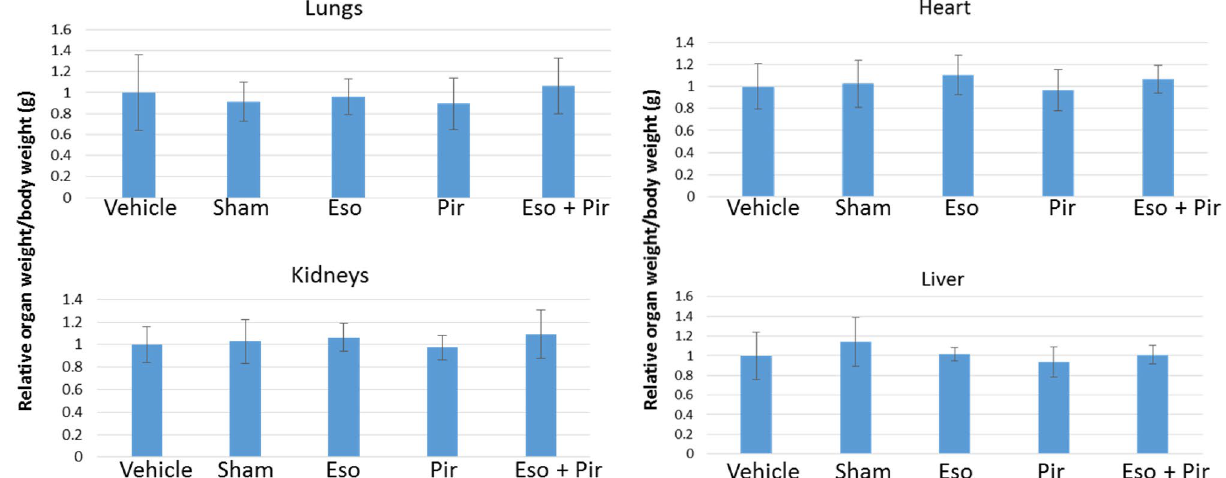
Figure 6. Measurement of organ weight in a TGFβ-induced lung fibrosis mouse model. The weight of the lungs, heart, liver and kidneys were normalized to the total body weight of the respective animal on the day of necropsy and was recorded for comparison. The weight of the kidneys and the lungs represent the total weight for the left and right organs. Combination of esomeprazole and pirfenidone did not significantly change the weight of any of the organs. Data is mean ± SEM from 10 to 12 animals per